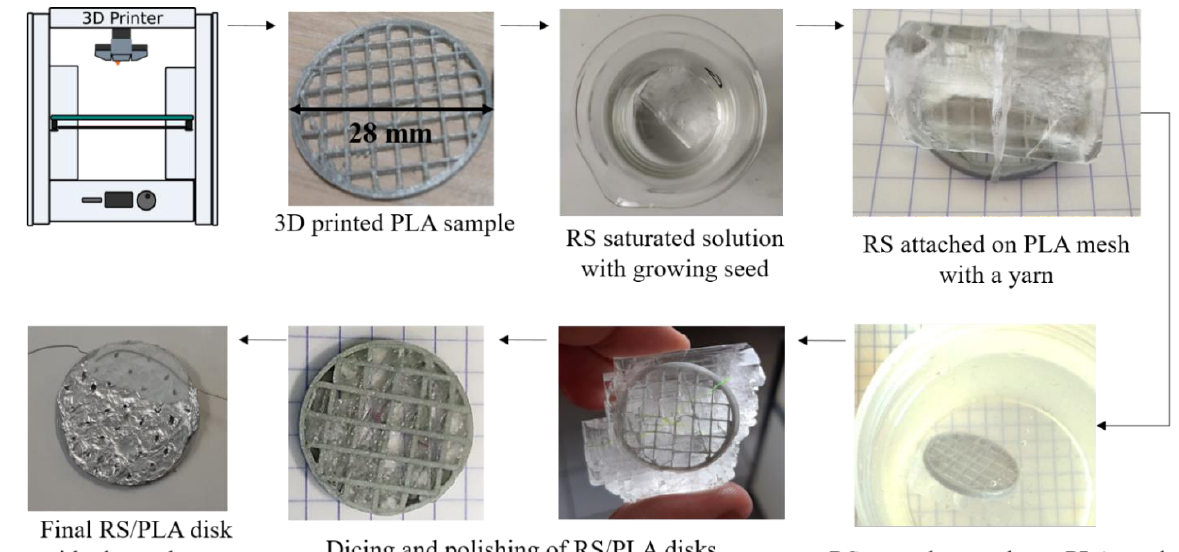
Figure 1. Manufacturing process flow of the piezoelectric samples.